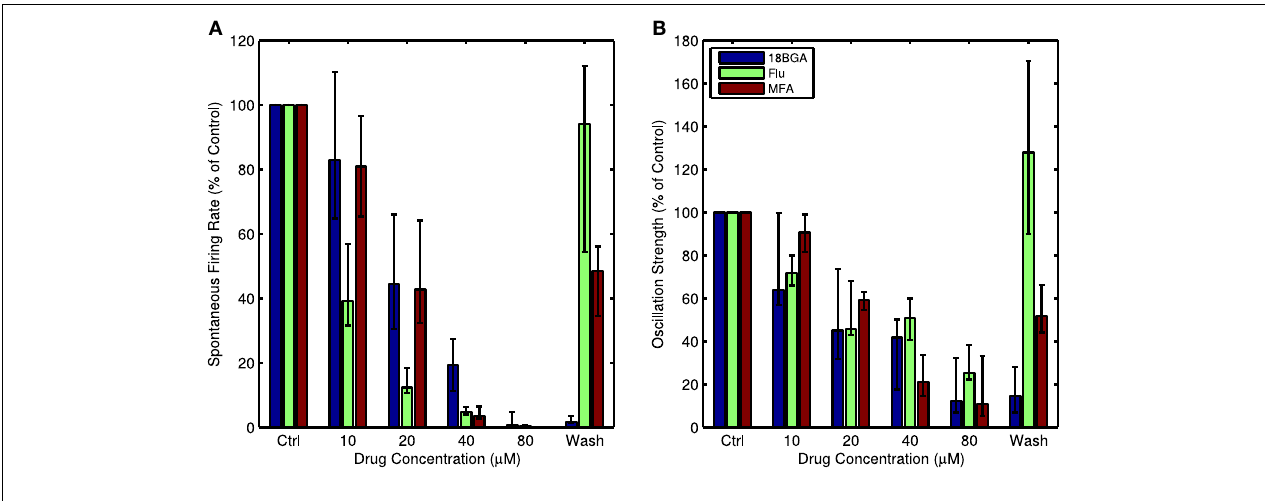
percentage of control conditions for each concentration of all three drugs, averaged over all recorded channels and all retinas. For both figures, error bars show the interquartile range (IQR).